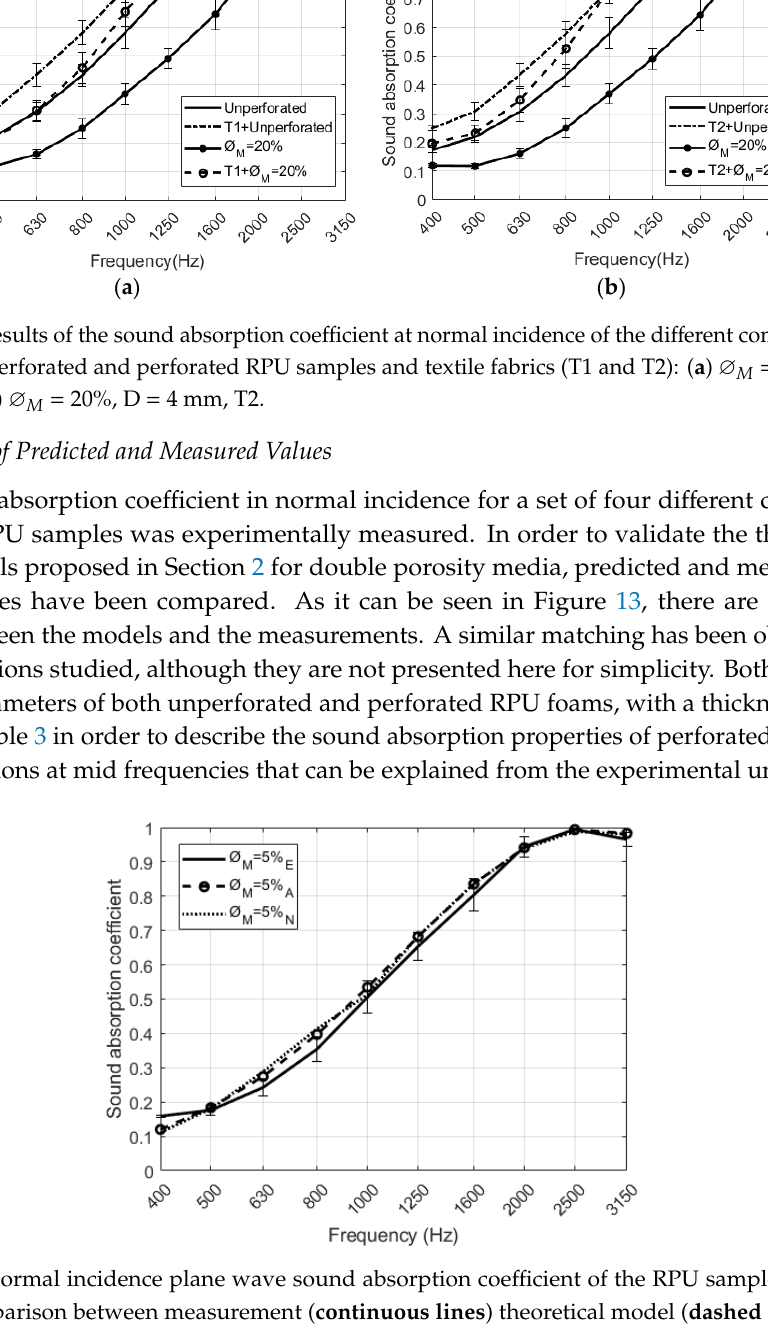
Figure 13. Normal incidence plane wave sound absorption coefficient of the RPU samples for D = 4 mm. Comparison between measurement ( continuous lines ) theoretical model ( dashed lines ) and numerical model ( dotted lines ).